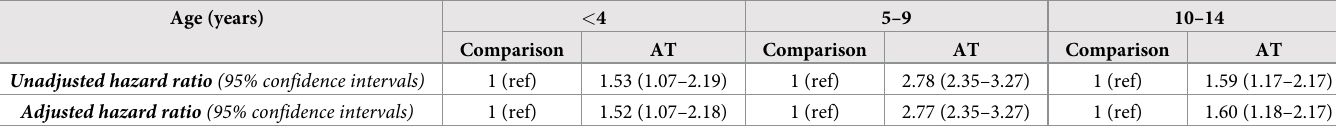
Table 3. Hazard ratios of asthma by age. Comparison AT Comparison AT Comparison AT Unadjusted hazard ratio (95% confidence intervals) Adjusted hazard ratio (95% confidence